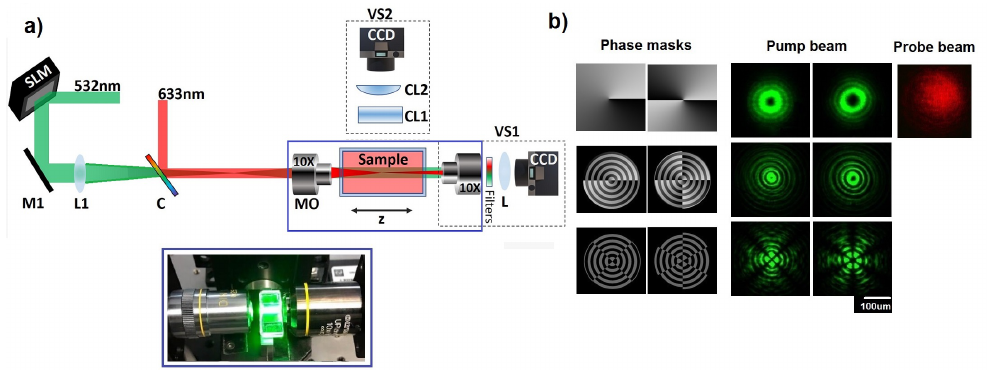
Figure 2. ( a ) Experimental set-up. SLM: phase-only spatial light modulator; M1: mirror; L1: convex lens; C: beam combiner; MO: microscope objective; VS1–VS2: visualization systems. VS1 includes a 10 × microscope objective and a convex lens (L), while VS2 combines a pair of perpendicularly oriented cylindrical lenses (CL1, CL2); in both cases images were recorded with color CCD cameras. The photograph below shows the laser illuminated cuvette between MO’s. ( b ) Left: various phase masks programmed in the SLM; center: corresponding transverse intensity profiles of the pump at the sample input; right: transverse intensity of the probe at the input. The same scaling applies to the images of all